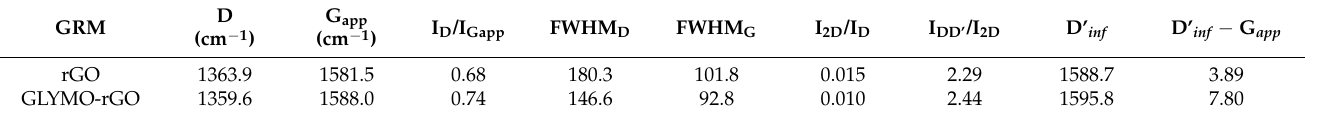
Figure 3. Raman spectra of GO, rGO and GLYMO-rGO. Table 1. Characteristic Raman peaks and intensity ratios for the GRMs used.